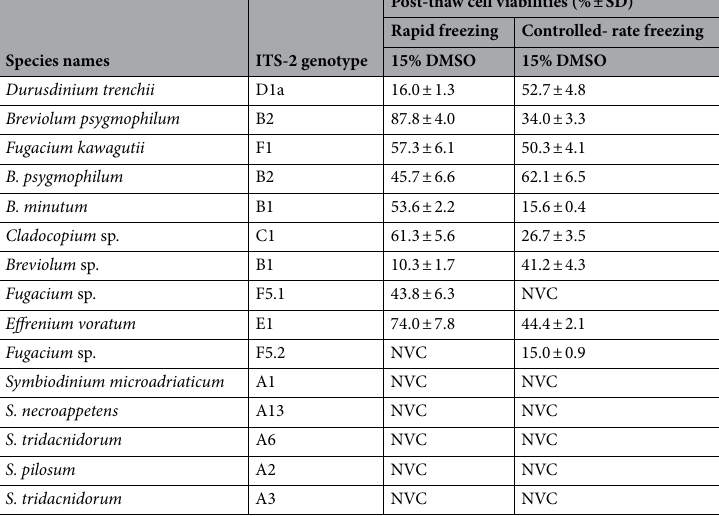
Table 2. Cell viabilities after the rapid freezing and controlled-rate freezing techniques using 15% dimethyl sulfoxide (DMSO) as the cryoprotectant agent (CPA). Values are mean percentage of three replicates (n = 3) ± standard deviation (SD). NVC no viable cells observed.